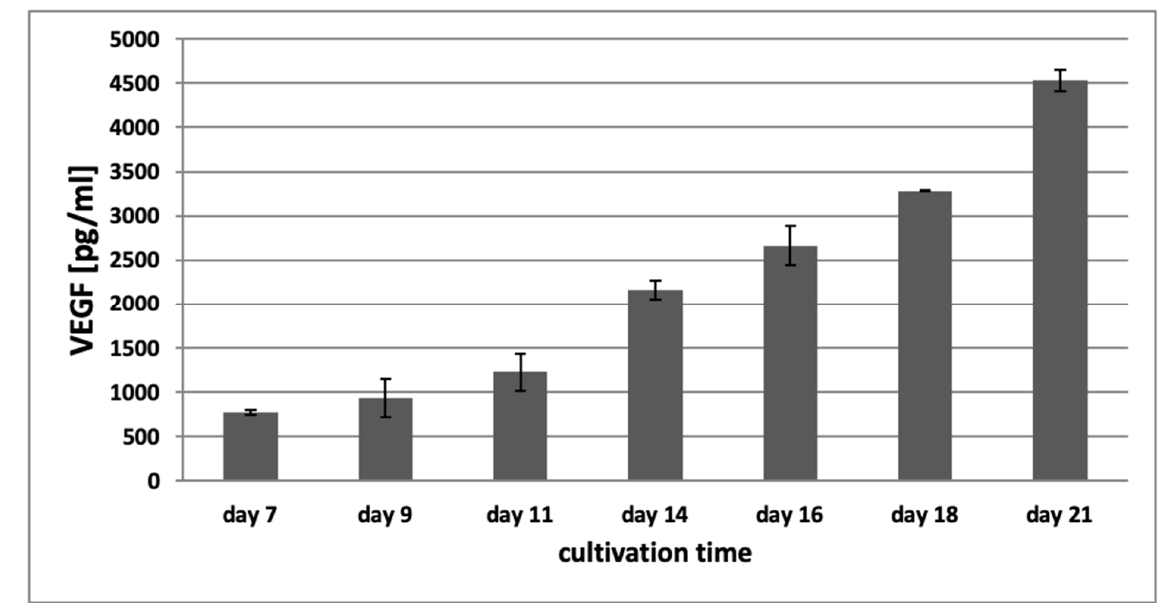
Figure 8. VEGF concentration in conditioned media of 3D hydrogel-based tumor-stroma cultures as determined by ELISA. The concentration of VEGF increases continuously over the course of 21 days in tumor-stroma models containing H838 spheroids, reaching a level almost six-fold above the initial VEGF concentration at day 21. Experiments were performed in duplicate.